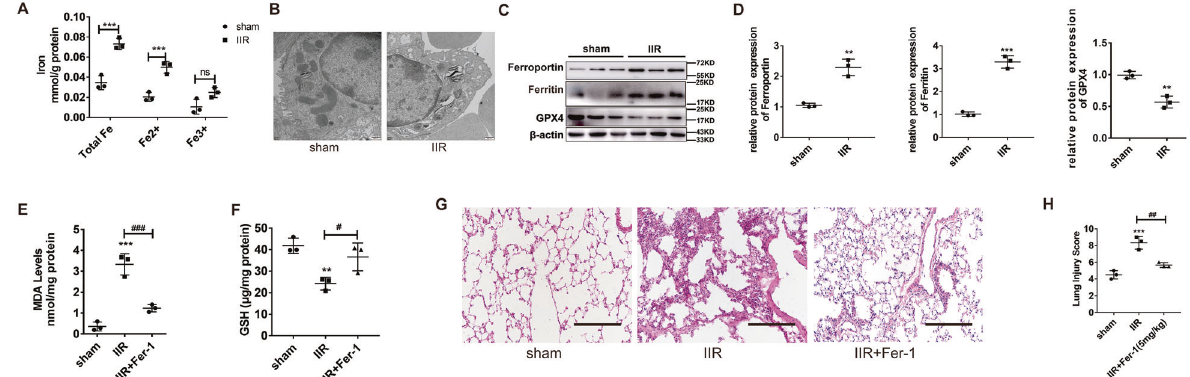
Fig. 1 II/R-induced ALI promotes ferroptosis. A Endogenous Fe levels in the lungs of IIR-ALI mice, as evidenced by Fe assay. B Representative transmission electron micrographs of lung ultrastructure. Scale bars: 500 nm. C , D Evaluation and quanti fi cation of the GPX4, ferritin, and ferroportin protein expressions, under all conditions. E Evaluation of the lipid peroxide MDA levels under all conditions. F GSH levels under all conditions. G HE staining of the murine lung tissues after IIR and IIR + Fer-1. Scale bars: 200 μ m. H The lung pathological damage score illustrating addition and decrease after Fer-1 administration, respectively. Data are expressed as mean ± SEM. * P < 0.05; ** P < 0.01; *** P < 0.001. Error bars denote standard error from three individual experiments.